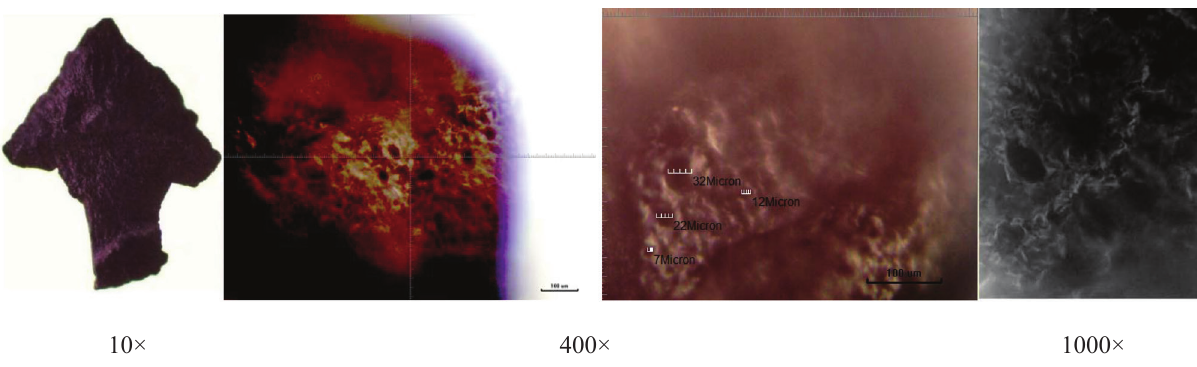
Fig. 2 – Digital microscopic images of ACSTA (10x – 1000х)